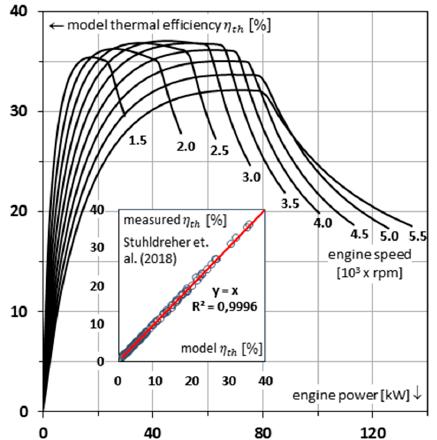
Figure 2. Brake thermal efficiency map of the test car and its parity with measured values, red line.